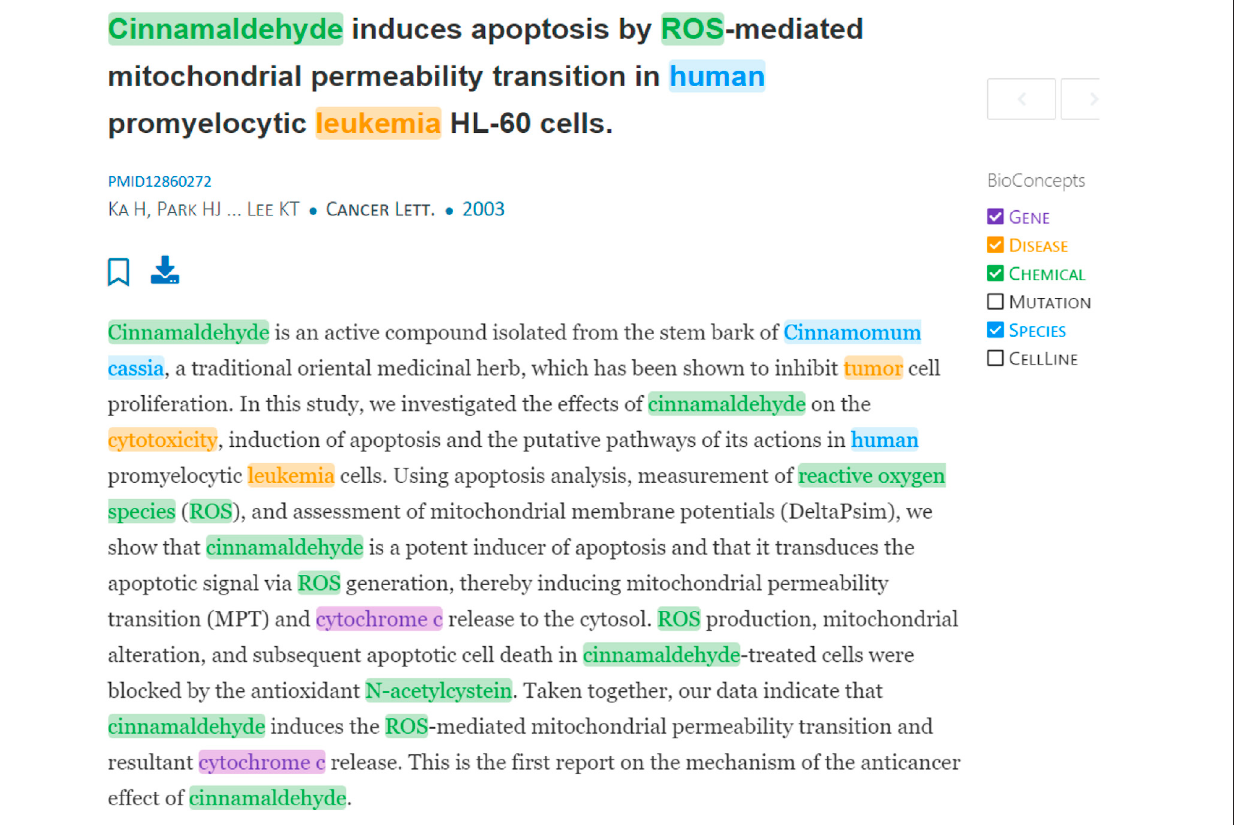
FIGURE 3 | Bio-concept annotation through the PTC web interface for an article with PMID 12860272.